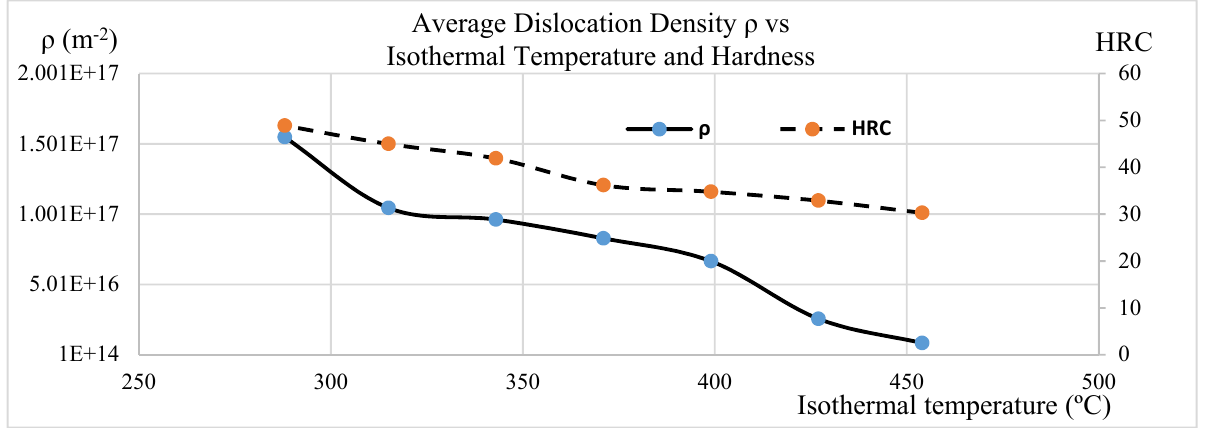
Figure 4. Isothermal temperature effect on dislocation density and hardness.